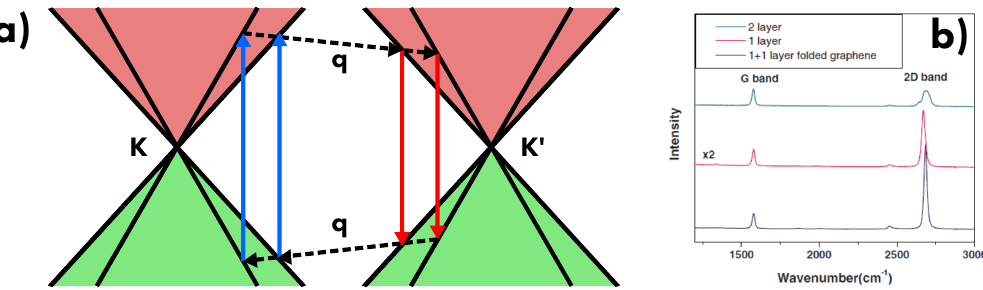
Figure 20. ( a ) Scheme of Fermi velocity influence on scattering process for 2D mode related to graphene folding. ( b ) Raman spectra of folded graphene compared to single- and double-layer graphene. Adapted with permission from Ref. [71]. Copyright (2008) American Physical